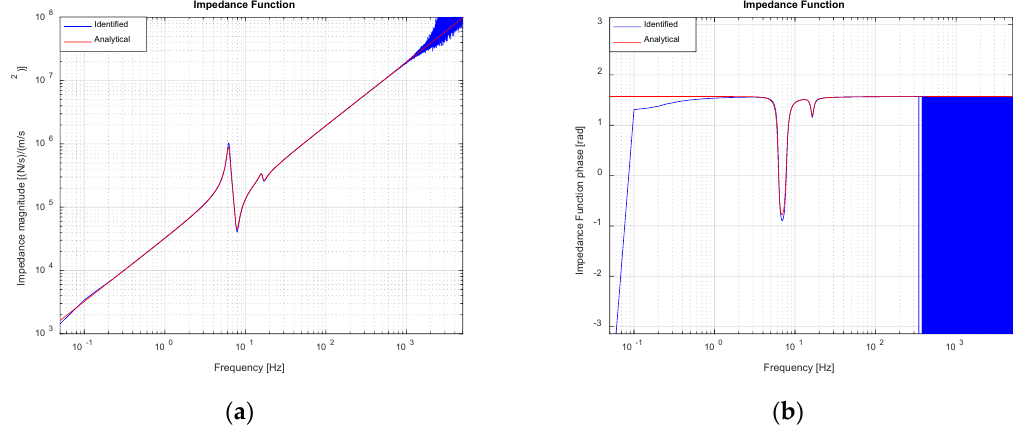
Figure 10. Identified and analytical IF (noise-free scenario): ( a ) Magnitude; ( b ) Phase.